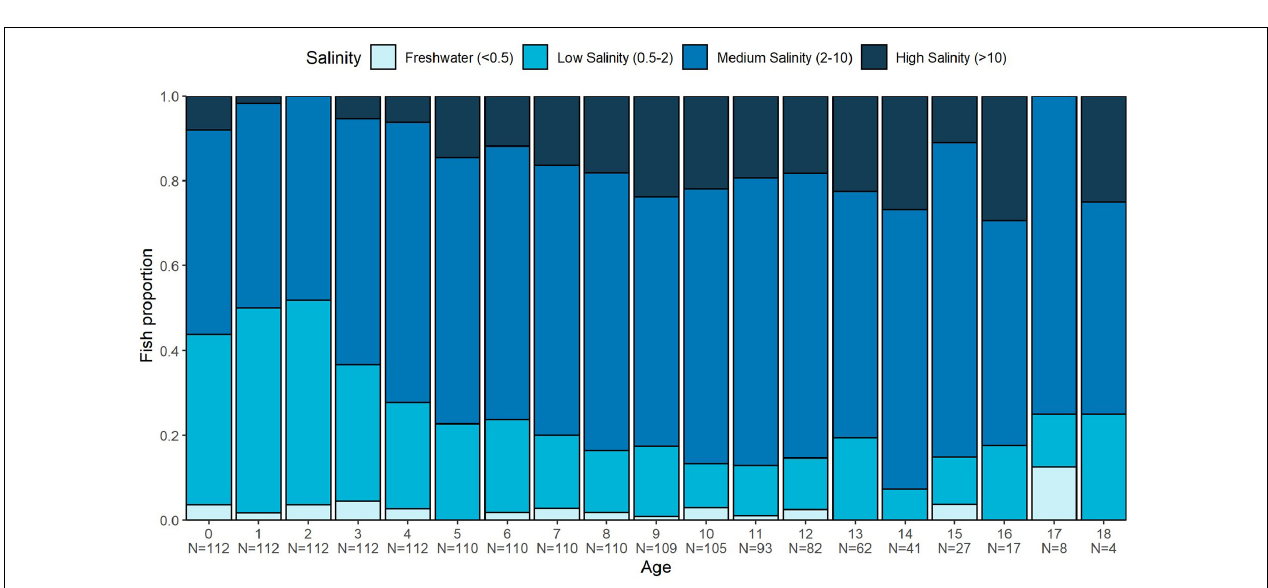
FIGURE 7 | Proportion of White Sturgeon ≤ 18 years of age observed in each of four salinity zones by year-post-hatch. Salinity zones were assigned to each year for each fish by converting the mean annual 87 Sr/ 86 Sr value into salinity estimates using the mixing model ( Figure 3 ).